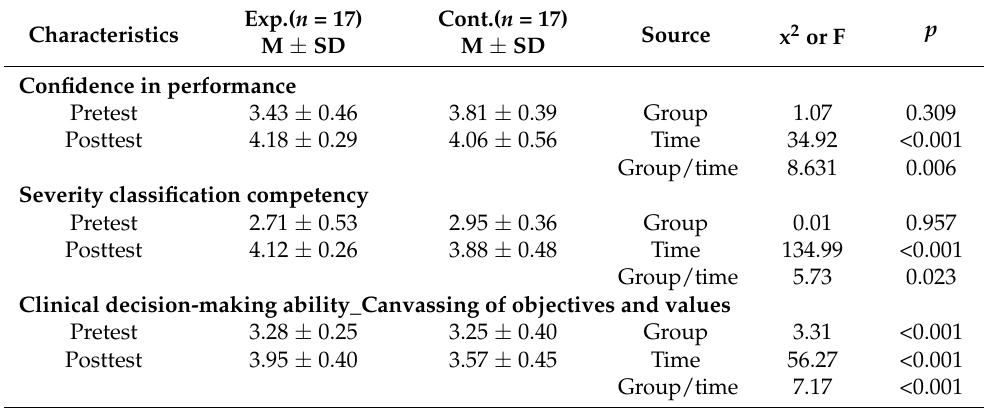
Table 3. Pretest–Posttest Mean Differences of Confidence in Performance and Clinical Decision- Making Ability between the Experimental and Control Groups Over Time ( n = 34).